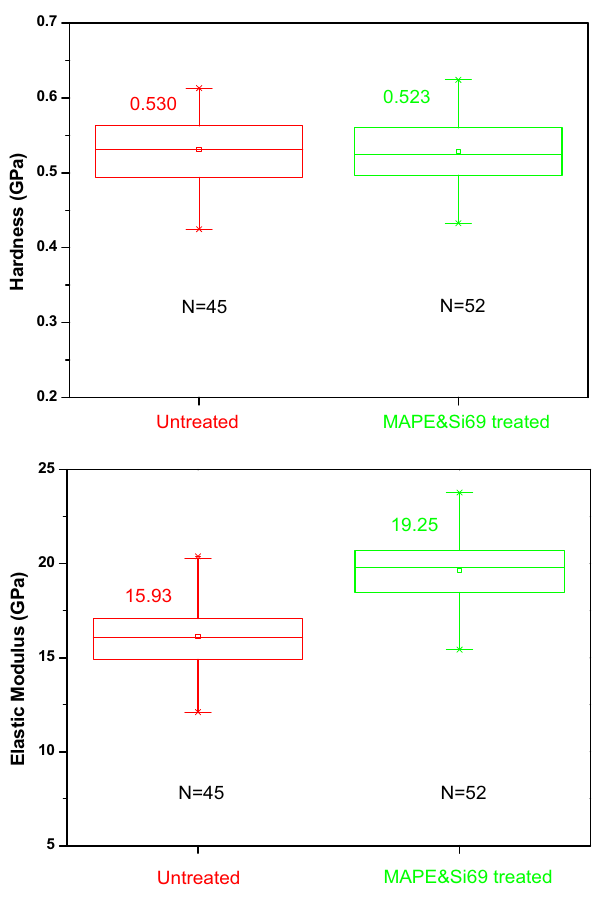
Figure 8: Nanomechanical properties of untreated and MAPE and Si69 treated RubWPC by